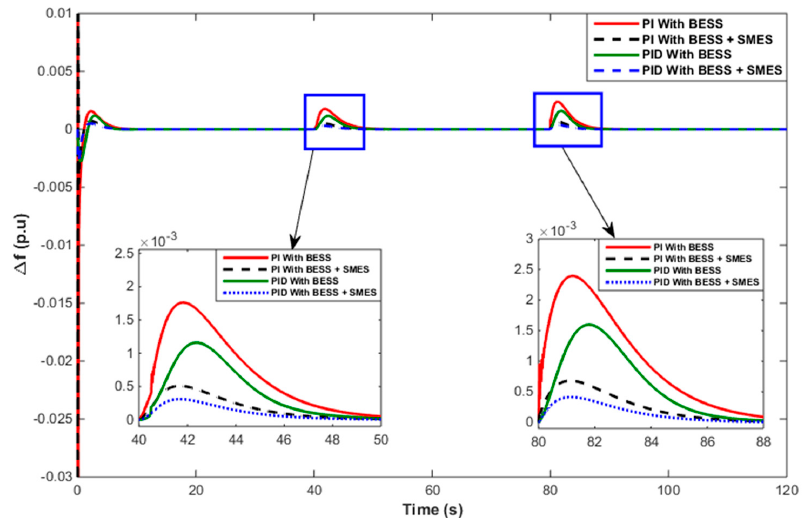
Figure 15. Comparative performances of the frequency responses of BESS (case 1) and BESS + SMES (case 3) with the FPA-optimized PI and PID controllers employed in a hybrid response model.